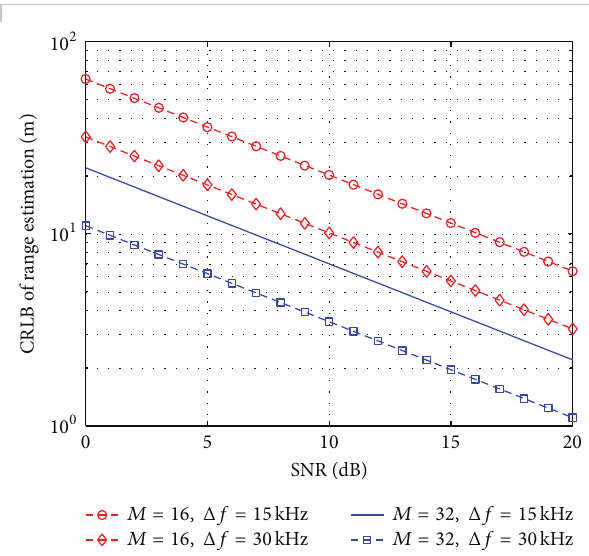
Figure 2: CRLB for estimating angle versus SNR when the range is known.